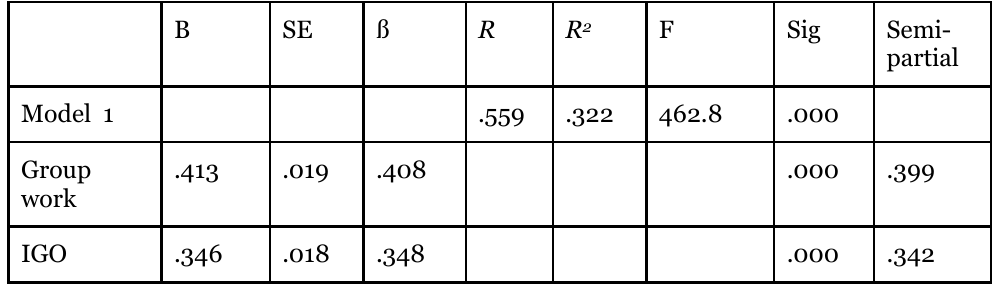
Standard Multiple Linear Regression of Offline Interaction and Intrinsic Goal Orientation on Germane